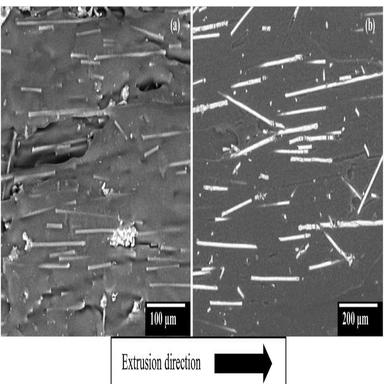
SEM images of the extruded bead surface of the (a) ABS/CF and (b) ABS/GF. Direction of extrusion is marked to refer the fiber directionality along the 3D printing bead.